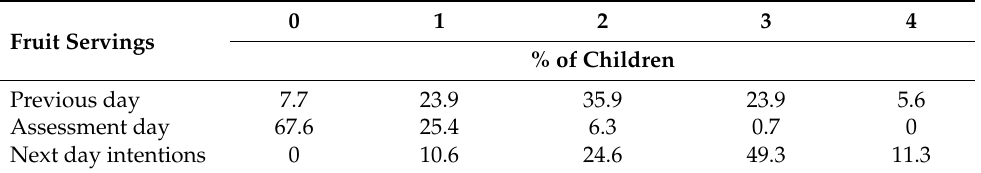
Table 4. Fruit servings consumed in two moments (previous day and assessment day), and fruit eating intentions